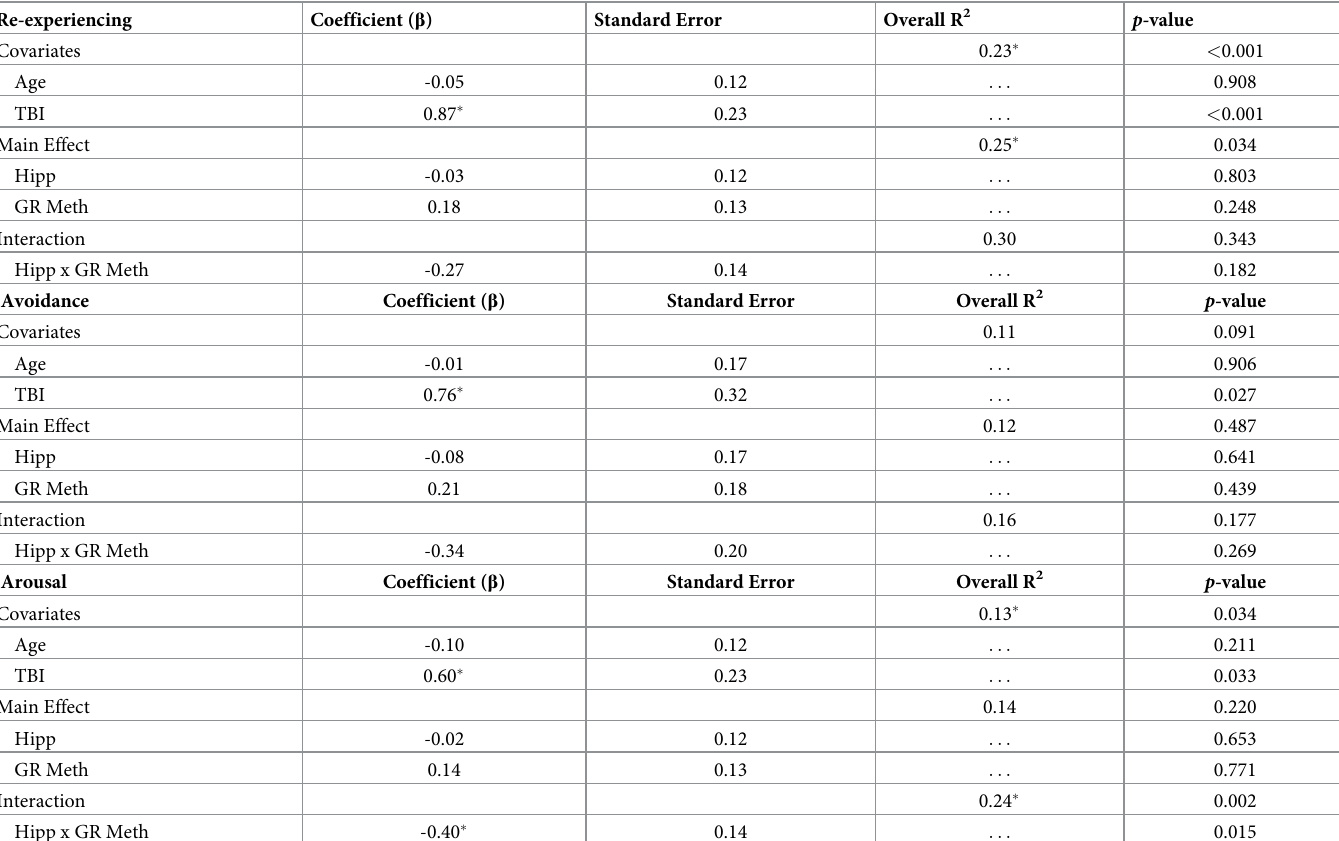
Table 3. Assessing the model in predicting different domains of